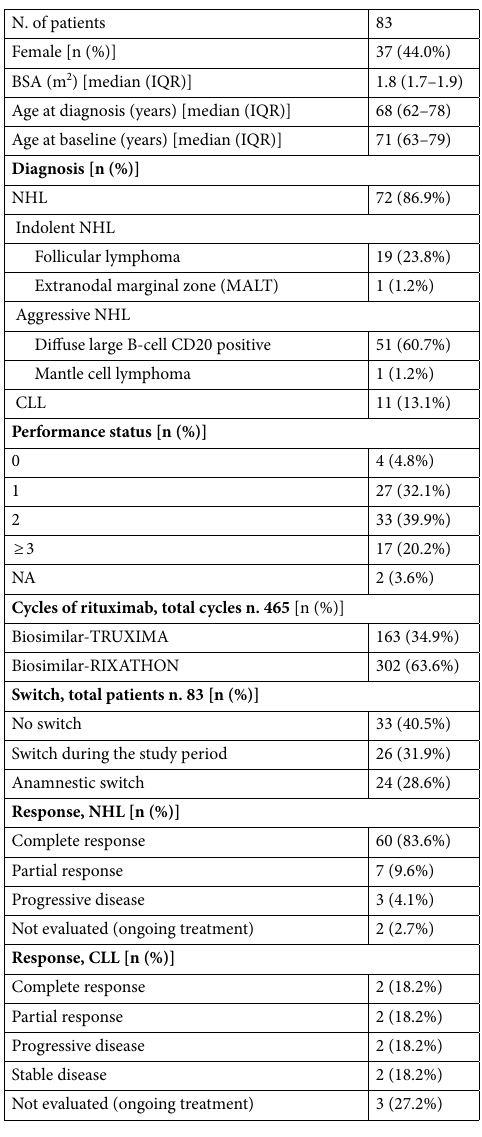
Table 1. Characteristics of patients. n number, BSA body surface area, IQR inter quartile range, NHL Non Hodgkin’s Lymphoma, CLL chronic lymphocytic leukemia, NA not